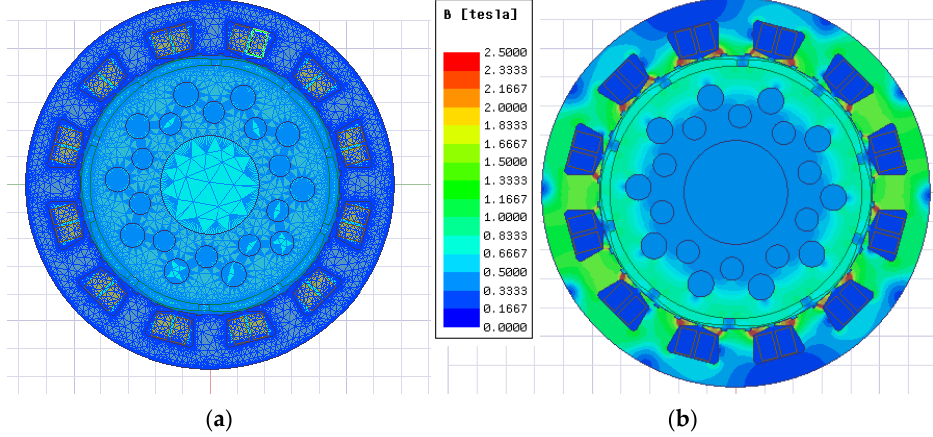
Figure 10. Meshing and magnetic density analysis of the PMSM: ( a ) meshing; ( b ) magnetic density analysis.